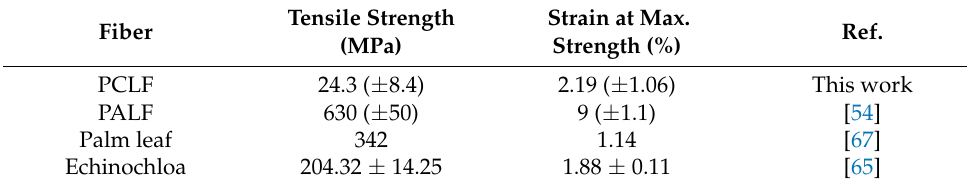
Figure 9. Some tensile curves for single PCLF. Table 5. Tensile strength and ultimate strain of leaf-extracted